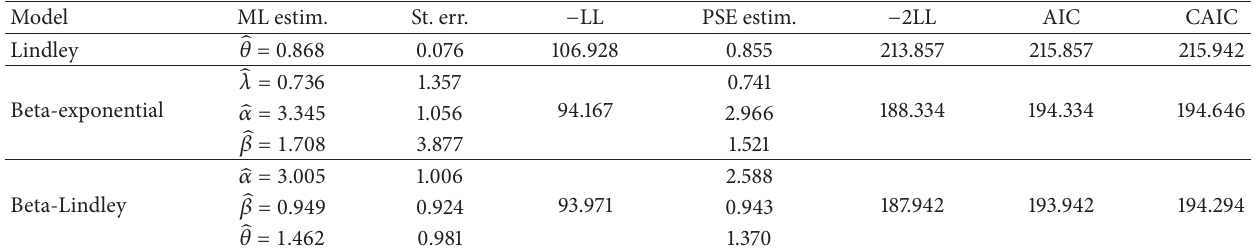
Table 2: The ML estimates, standard error, log-likelihood, AIC, and CAIC for Data Set 2. Model